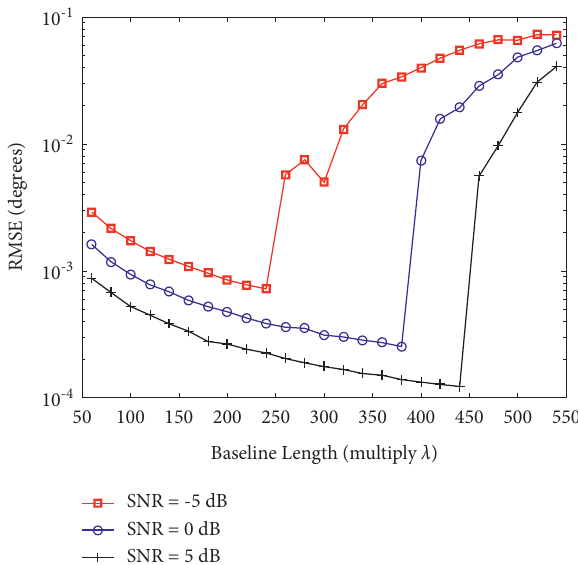
Figure 13: The simulation results of RMSE as a function of the baseline